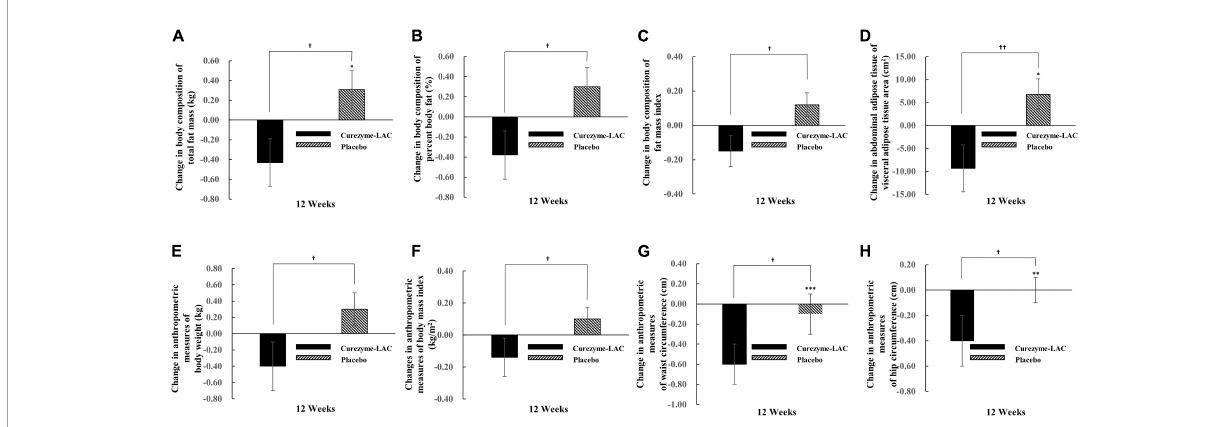
FIGURE2 Changes in body composition, abdominal adipose tissue and anthropometric measurements in individuals receiving Curezyme-LAC group or placebo group. (A) Changes in body composition of total fat mass (kg), (B) changes in body composition of percent body fat (%), (C) changes in body composition of fat mass index, (D) changes in abdominal adipose tissue of visceral adipose tissue area (cm 2 ), (E) changes in anthropometric measures of Body weight (kg), (F) changes in anthropometric measures of body mass index (kg/m 2 ), (G) changes in anthropometric measures of waist circumference (cm), (H) changes in anthropometric measures of hip circumference (cm). Data are expressed as the mean ± SE. Linear mixed-effect model adjusted with institute and MEDFICTS for 12 weeks was used to analyze the group x period (week) for 12 weeks. *Indicates a significant difference from the baseline ( p < 0.05; repeated measures ANOVA Contrast test). **Indicates a significant difference from the baseline ( p < 0.01; repeated measures ANOVA Contrast test). ***Indicates a significant difference from the baseline ( p < 0.001; repeated measures ANOVA Contrast test). † Indicates significant differences between the Curezyme-LAC group and the placebo group ( p < 0.05; repeated measures ANOVA Contrast test), †† indicate significant differences between the Curezyme-LAC group and the placebo group ( p < 0.01; repeated measures ANOVA Contrast